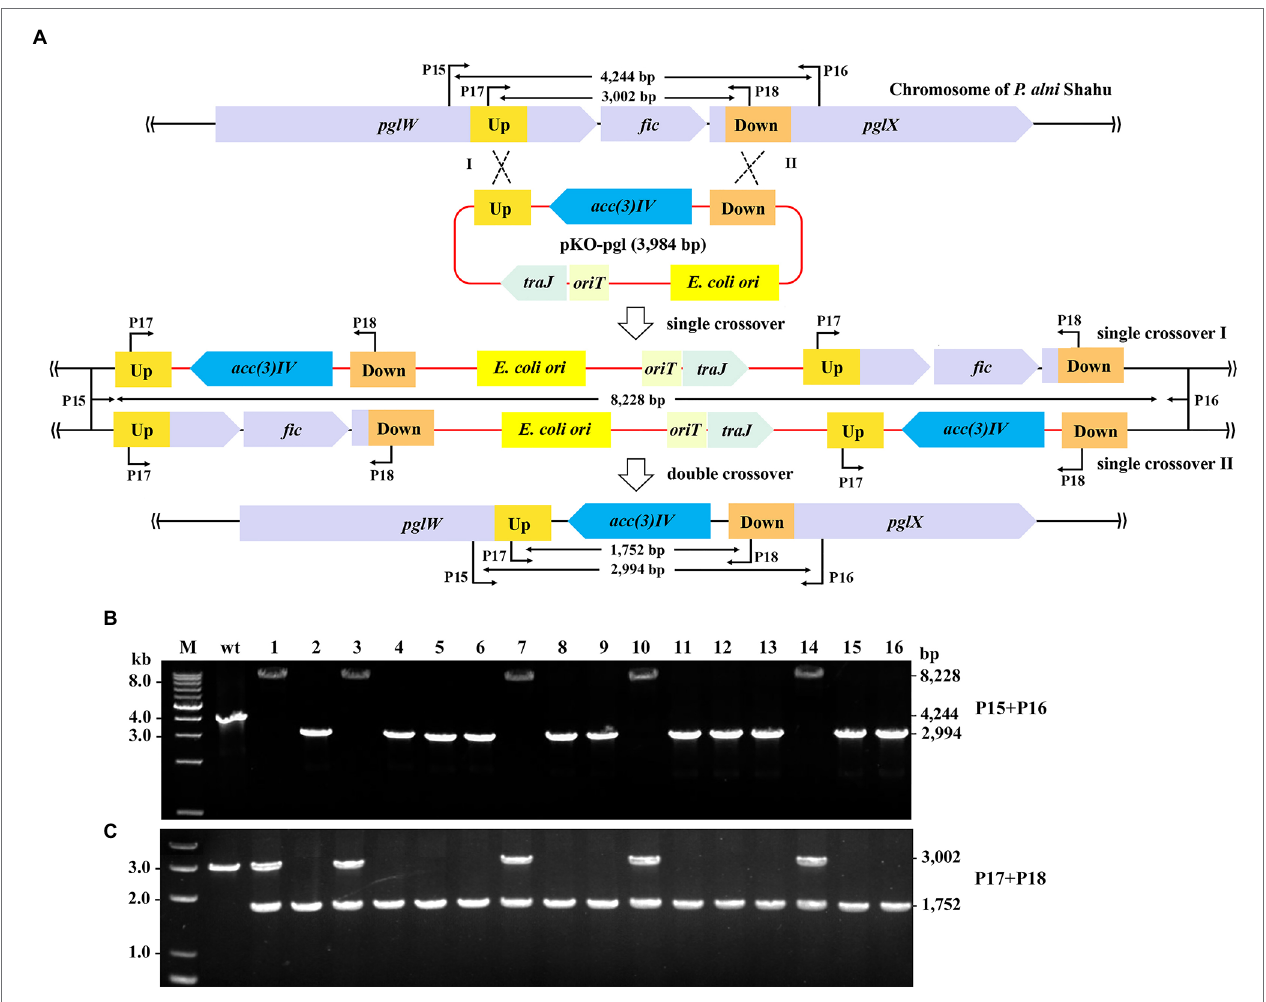
FIGURE 3 | Gene deletion in P. alni Shahu via homologous recombination. (A) Scheme of deletion of the pgl genes using a suicidal non-replicating plasmid, pKO- pgl. Recombination between either the homologous upstream (Up) arms (Single crossover I), or downstream (Down) arms (Single crossover II), would result in integration of the entire plasmid into to the chromosome; while double crossover recombination was expected to occur, eventually leading to replacement of the target genes with the apramycin resistance marker, acc(3)IV . (B,C) PCR screening of pgl :: acc(3)IV recombinants using primer sets of P15 + P16 (B) and P17 + 18 (C) . Predicted sizes of PCR products in wild-type (wt) and recombinants of single or double crossover recombination are indicated. M, DNA size